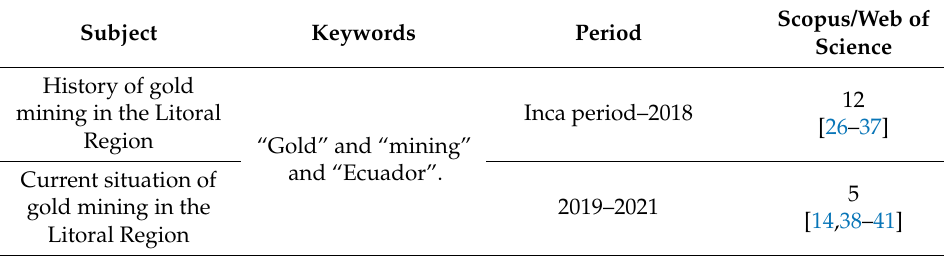
Table 2. Methodological process for the bibliographic review.